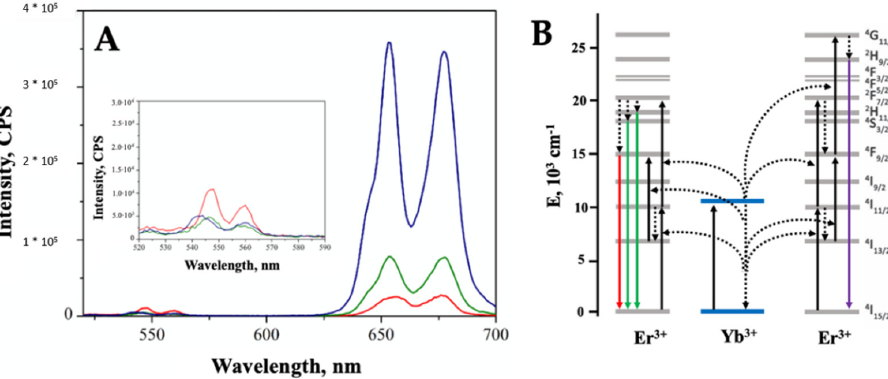
Figure 4. ( A ). UC emission spectra of ZEY2 (curve a, red), ZEY5 (curve b, green), and ZEY10 (curve c, blue) under NIR excitation (980 nm laser, power: 1.24 W); ( B ). Schematic illustration of UC processes and involved levels.